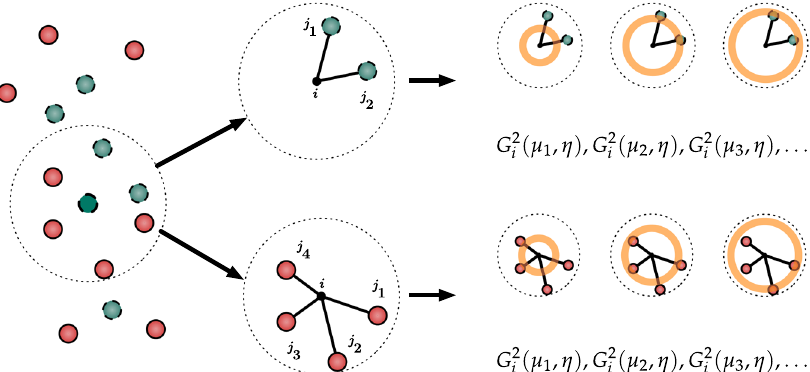
ð μ ; η Þ (Eq. (7)) for increasing values of μ . The local environment of a central atom is i